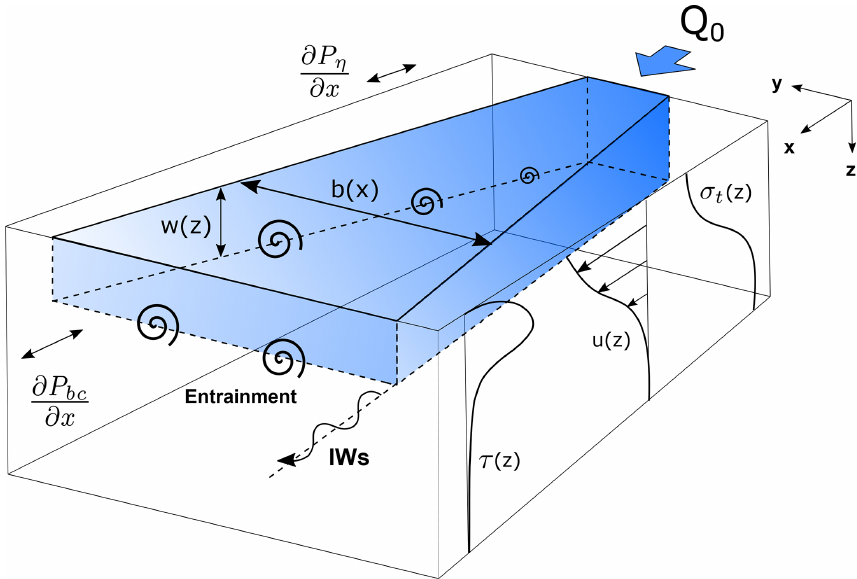
Figure 8. Schematic representation of the terms in the along-channel plume momentum budget, including near-field vertical structure. The plume is the blue shaded box fed by inflow Q 0 . The increasing width of the plume in the across-channel direction is b and the decreasing thickness of the plume is h . Vertical profiles of σ t , along-channel velocity ( u ) and turbulence stress ( τ ) are shown. The baroclinic ( P bc ) and barotropic ( P η ) components of pressure and the vertical entrainment velocity ( w ) are indicated. Entrainment between the plume and ambient is illustrated, and internal waves (IWs) propagate along the base of the